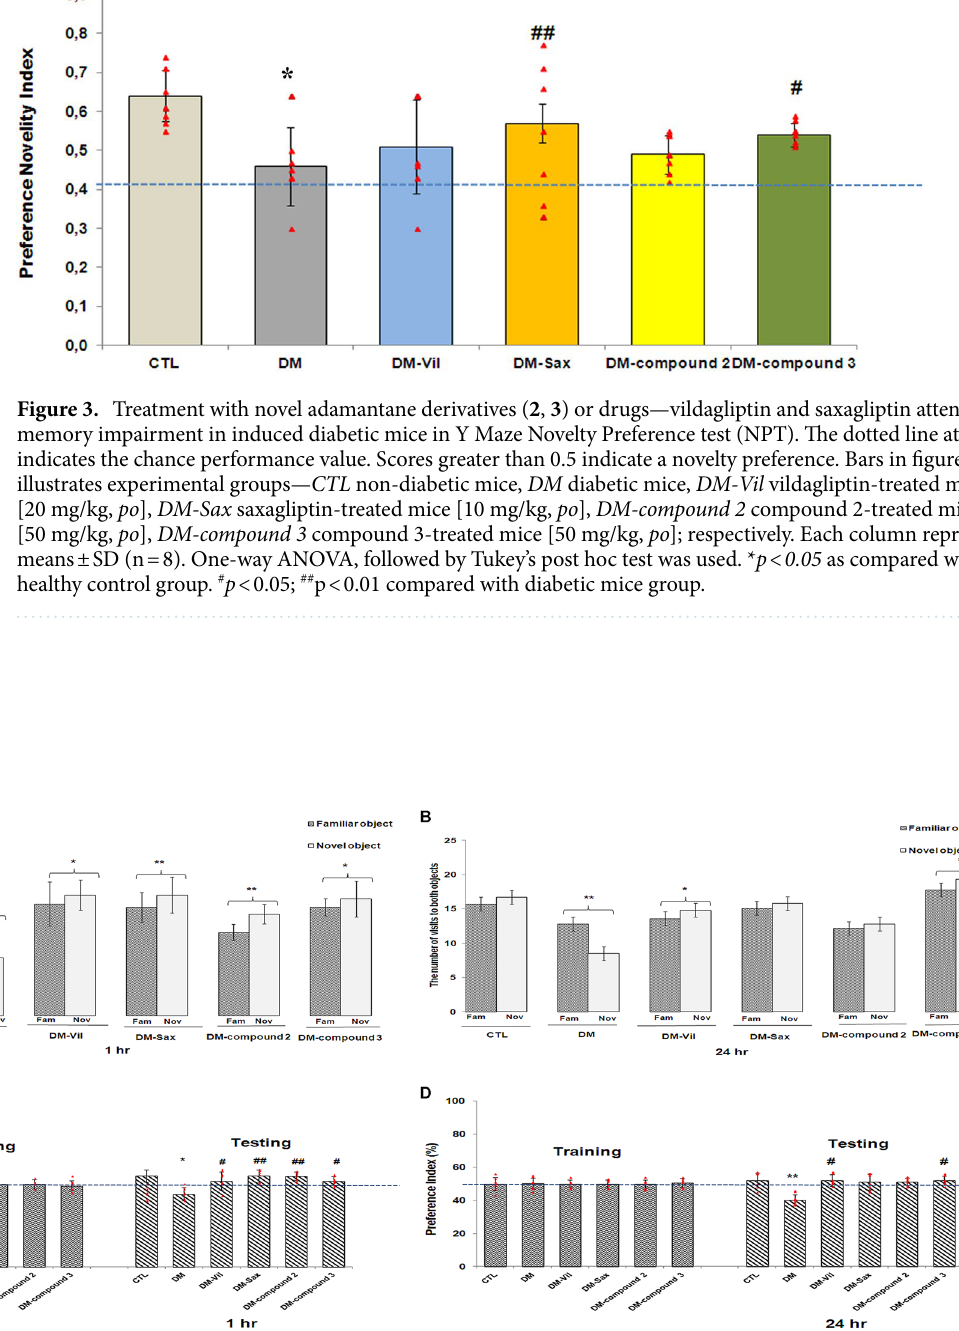
Figure 4. Treatment with novel adamantane derivatives ( 2 , 3 ) or drugs—vildagliptin and saxagliptin, attenuates memory impairment in induced diabetic mice in novel object recognition (NOR) test ( A – D ). Novel adamantane derivatives ( 2 , 3 ) or vildagliptin and saxagliptin were administered (on the last day 2-weeks experiment) 1 h before the training session. Testing sessions were performed 1 h ( A , C ), or 24 h ( B , D ) after the training session. The recognition memory was measured by the novel object recognition test where the mice were allowed to explore the familiar (Fam) and novel (Nov) objects for 5 min. Bars in the figures ( A , B ) illustrates the number of visits to both objects by different groups of mice in testing stage; bars in figures ( C , D ) illustrates the preference index (%) for each group. Experimental groups— CTL non-diabetic mice, DM diabetic mice, DM‑Vil vildagliptin-treated mice [20 mg/kg, po ], DM‑Sax saxagliptin-treated mice [10 mg/kg, po ], DM‑compound 2 compound 2-treated mice [50 mg/kg, po ], DM‑compound 3 compound 3-treated mice [50 mg/kg, po ], respectively. Each column represent means ± SD (n = 8). ( A , B ) *p < 0.05; **p < 0.01 comparison of the exploration count of a new object to the familiar object by the mice in a given experimental group. ( C , D ) *p < 0.05; **p < 0.01 compared with healthy control group. ( C , D ) # p < 0.05; ## p < 0.01 compared with diabetic mice